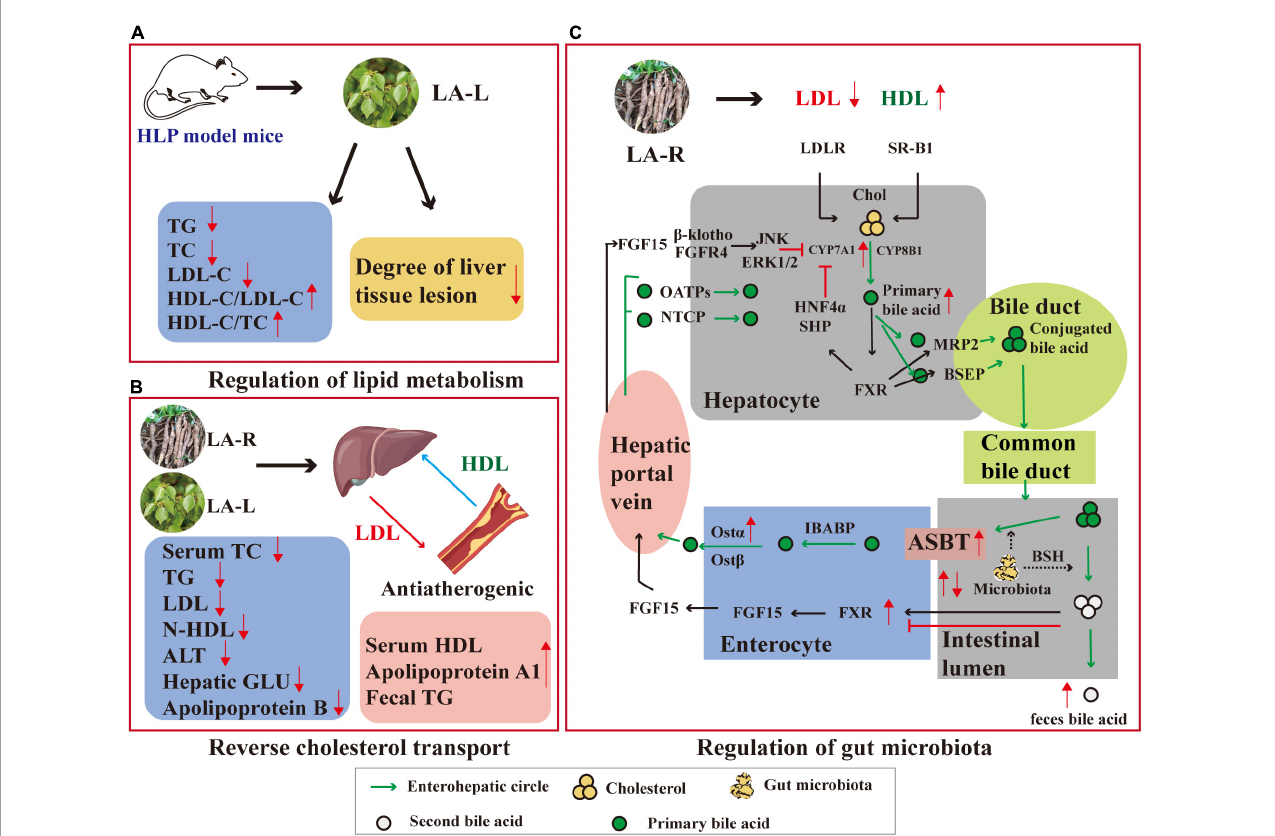
FIGURE6 Anti-hyperlipidemic mechanism of action of L. aggregata . (A) Regulation of lipid metabolism. (B) Reverse cholesterol transport. (C) Regulation of gut microbiota. CYP8B1, Cytochrome P450, family 8, subfamily B, polypeptide 1; ERK, extracellular regulated protein kinases; FGF, recombinant fibroblast growth factor; β -klotho, a single-transmembrane receptor; OATPs and NTCP, drug transporters; MRP2 and BSEP, bile acid transporters; FXR, farnesoid X receptor; ASBT, apical sodium-dependent bile acid transporter; OST, organic solute transporter; BSH, bile salt hydrolase; HNF4 α , hepatocyte nuclear factor 4 α ; SHP, small heterodimer